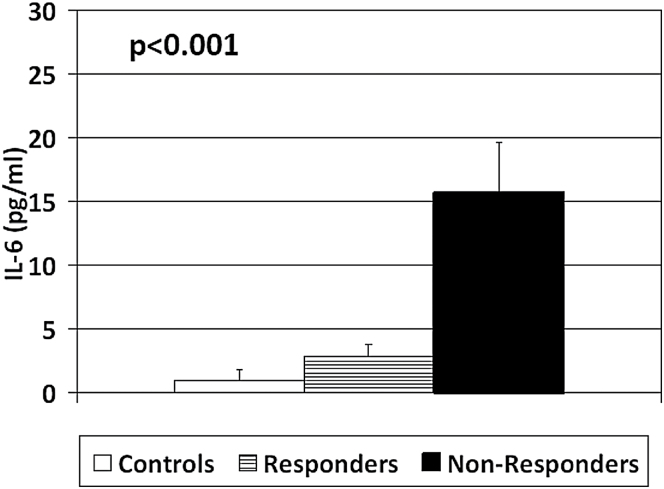
Baseline mean ± standard error of the mean interleukin (IL)-6 levels in Controls, Responders, and Non-Responders. P value indicates the significance of the comparison with the one-way ANOVA.